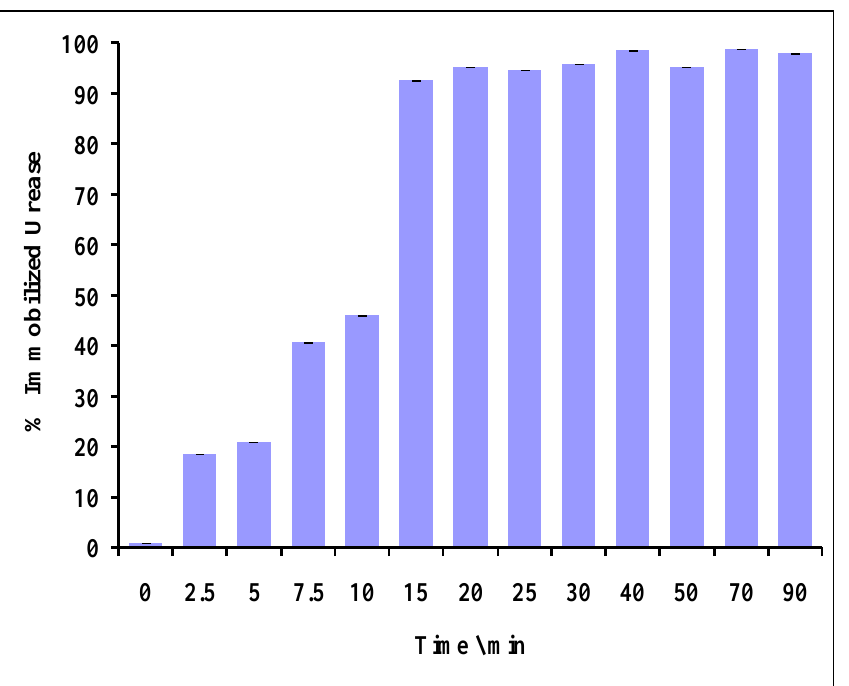
Figure 7. Urease incubation period versus percentage of immobilized urease ( n =